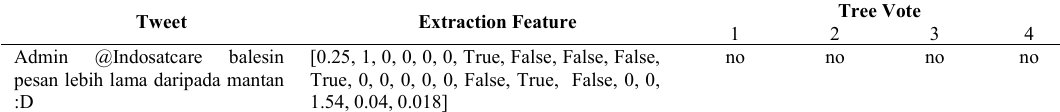
TABLE 3 E XAMPLE OF TAKING VOTES ON THE R ANDOM F OREST C